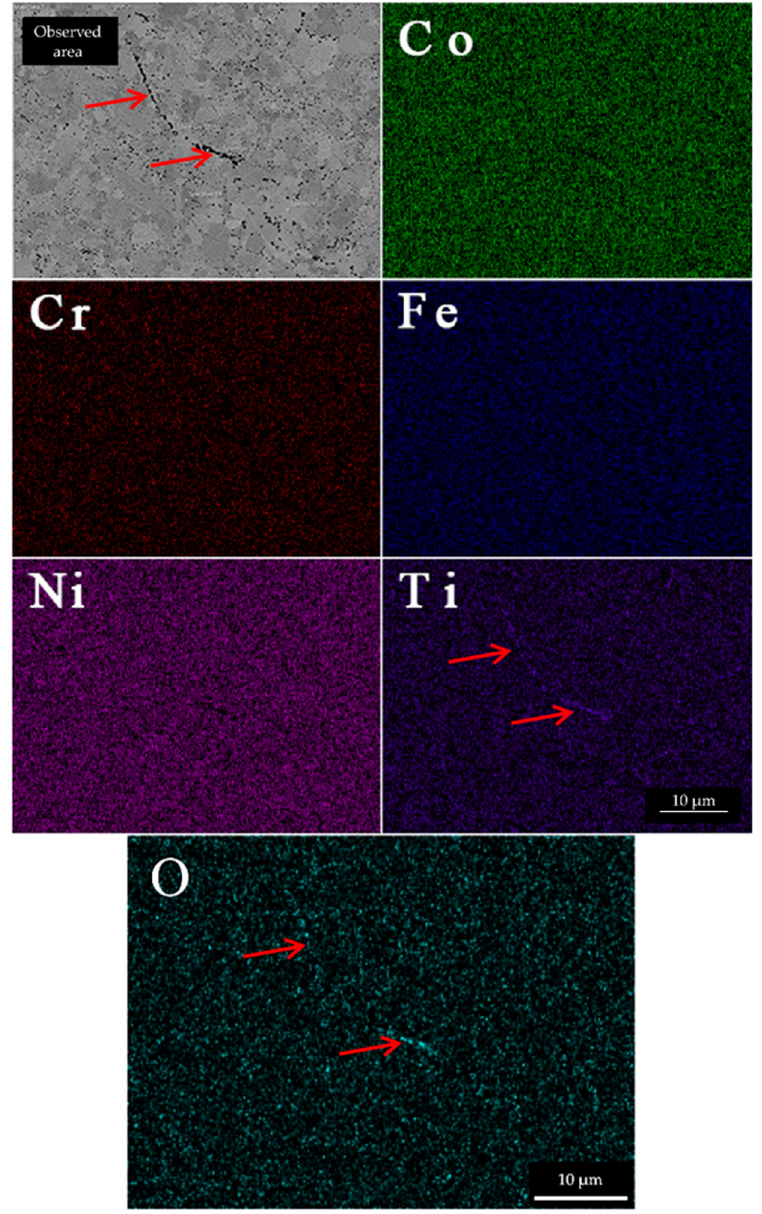
Figure 5. Representative EDS elemental maps of Ti0.5 alloy. The elements are evenly distributed in the alloy. The only exception is Ti, which concentrates in the oxide particles. The Ti- enriched oxide strings highlighted by red arrows denominate powder particle boundaries prior to SPS densification, but they are also present inside of former particles. The signal of O is strongest in the same regions as Ti, most noticeably in the region highlighted by red arrows of oxide strings.